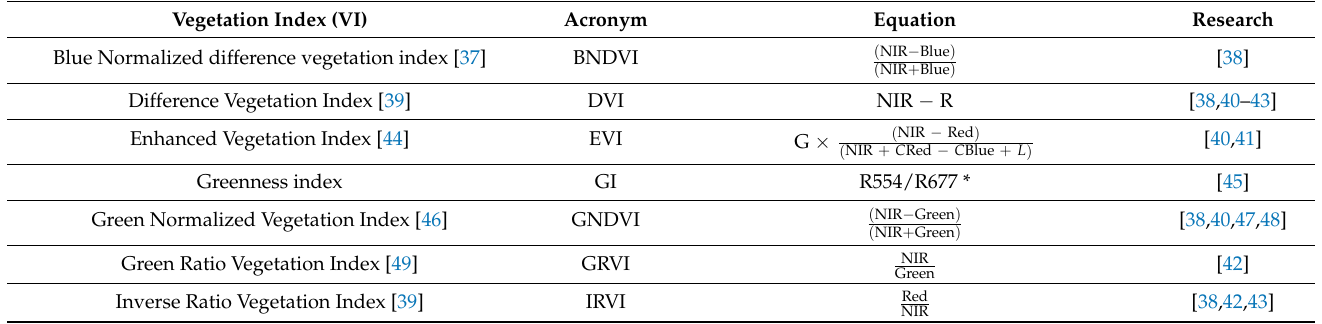
Table 1. The main vegetation indices (VIs) used in remote sensing research in olive